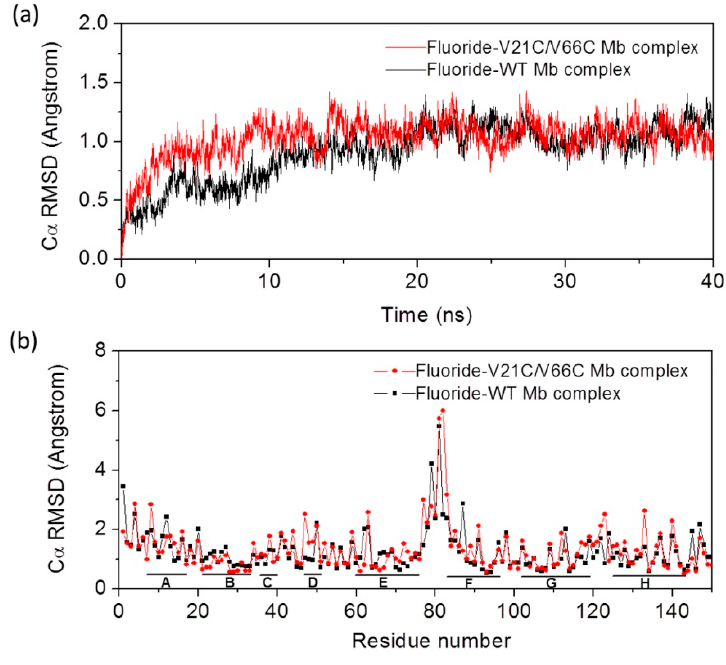
Figure 2. ( a ) Root mean square deviation (RMSD) for fluoride binding to WT Mb and V21C / V66C Mb from the starting structure as a function of time; ( b ) the average RMSD of each residue for the last 20 ns. The eight α -helices (H A –H H ) are indicated by short solid lines at the bottom.